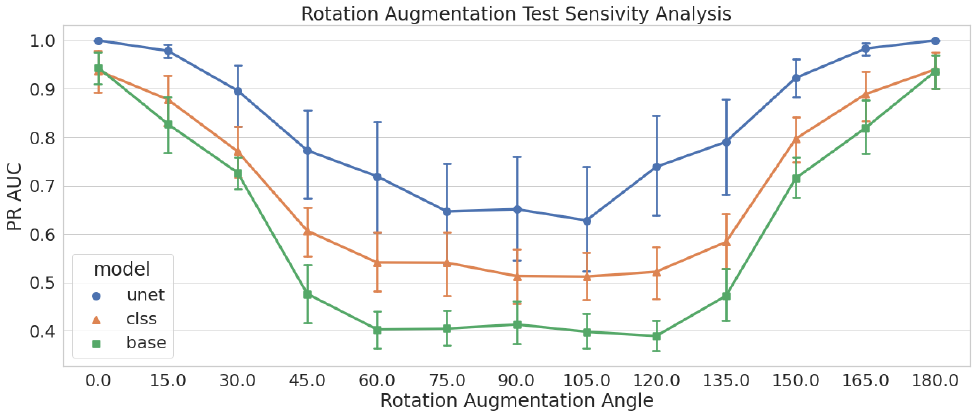
Figure 2. Performance of models trained with no augmentations tested on all rotation augmentations sets. Models are measured using the PR AUC metric, and we see models drop to their lowest performance around the 90 ◦